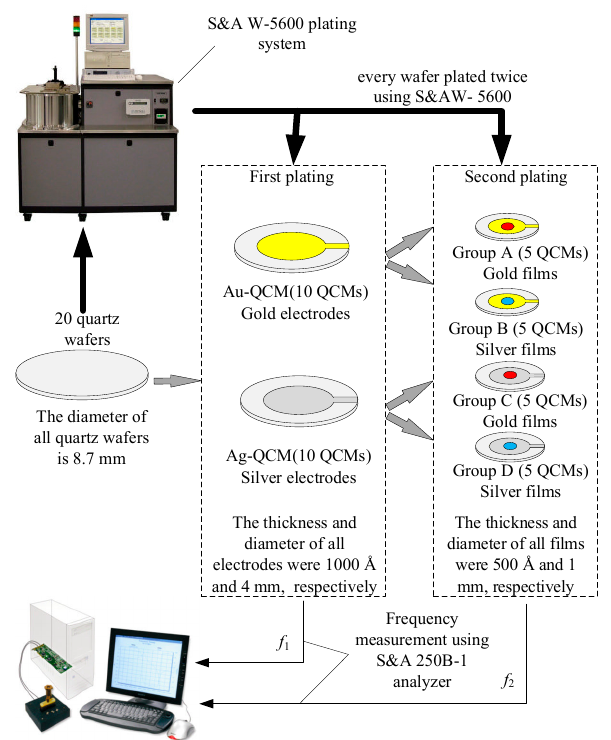
Figure 1. Schematic diagram of the experimental setup.